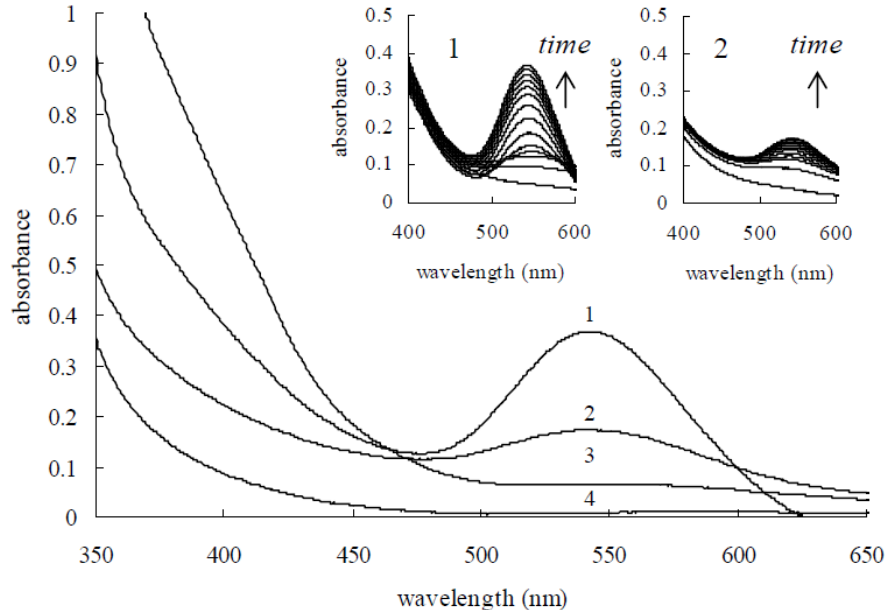
Figure 6. UV-visible spectra recorded for the formation of gold nanoparticles. UV-visible spectra recorded for a solution containing: ( 1 ) 0.10 mM Mb, 0.50 mM HAuCl 0.75 mM Hydroquinone; ( 2 ) 0.10 mM Mb and 0.50 mM HAuCl and 0.75 mM Hydroquinone; and ( 4 ) 0.50 mM HAuCl with time, so no enlarged drawings are